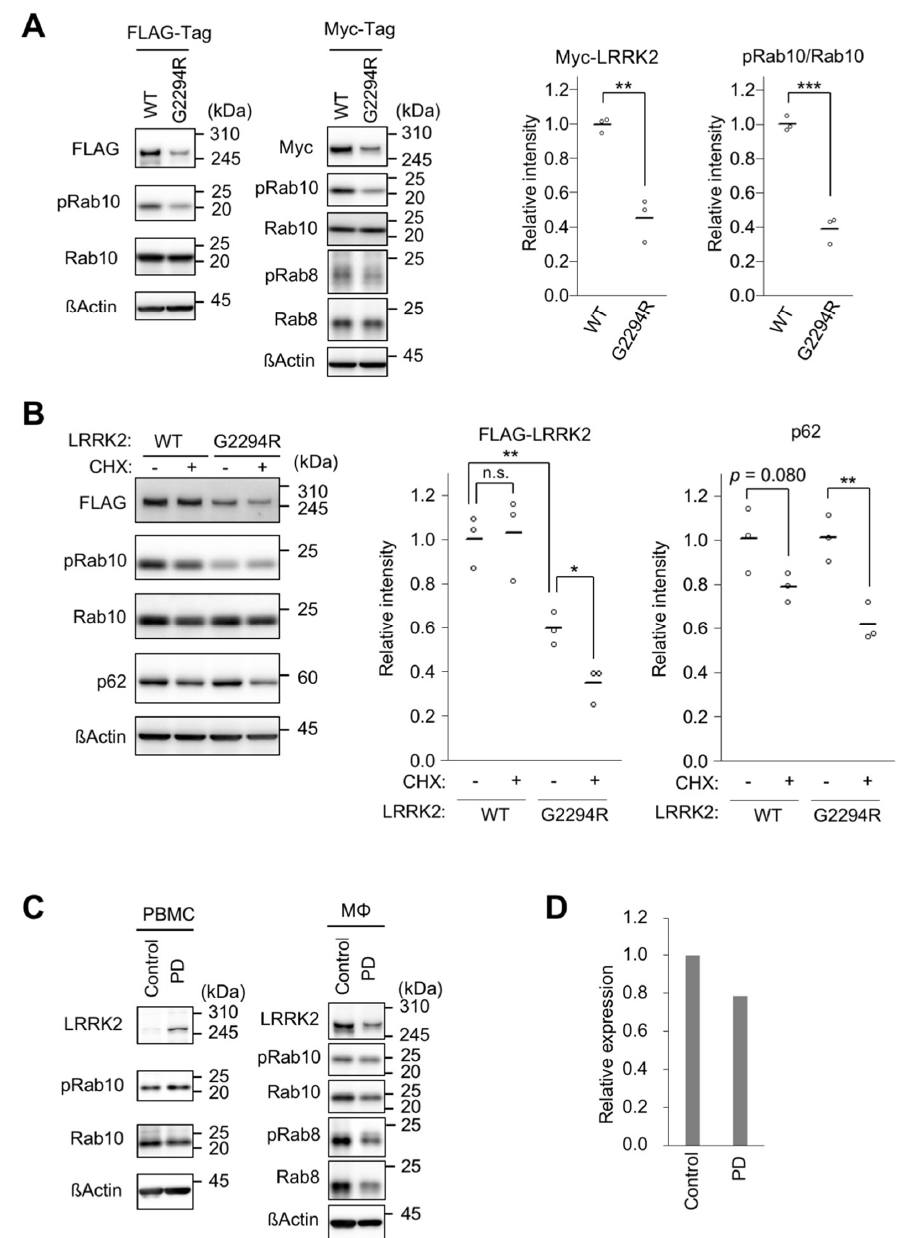
Figure 2. LRRK2 is destabilized by the p.G2294R variant. ( A ) The protein levels of LRRK2. Lysate from HEK293T cells transiently transfected with FLAG-LRRK2 (left) or Myc-LRRK2 (right) was analyzed by Western blot with indicated antibodies. The graphs (bars represent the mean; white circles indicate each value) represent relative Myc-LRRK2 levels normalized with ß-actin, and the ratio of pRab10 to total Rab10. Note that the anti-pRab8 we used crossreacts with pRab3, pRab10, and pRab35 [14]. n = 3 biological replicates; Student’s t -test. ß-actin served as a loading control. pRab10 and Rab10 phosphorylated at T73; pRab8, Rab8 phosphorylated at T72. ( B ) LRRK2 p.G2294R is unstable. HEK293T cells transiently transfected with FLAG-LRRK2 WT or p.G2294R were treated with (+) or without ( − ) 100 µg/mL cycloheximide (CHX) for 8 h and analyzed by Western blot. The left graph shows that the relative LRRK2 intensity normalized with ß-actin was decreased by p.G2294R mutation, which was further accelerated by CHX treatment. The right graph shows the relative p62 intensity normalized with ß-actin. The data (bars represent the mean; white circles indicate each value) are from 3 biological replicates; Student’s t -test. n.s., not significant. ( C ) The endogenous protein levels of LRRK2 and the indicated proteins in PBMCs and macrophages (Mø) from the PD patient with LRRK2 p.G2294R, and a normal control. ( D ) The relative quantification of endogenous LRRK2 normalized with ß-actin in